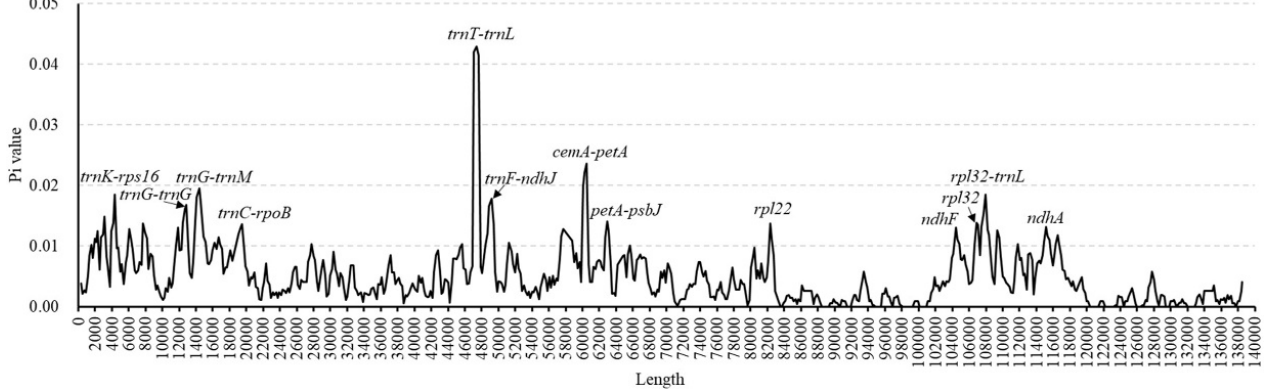
Figure 6. Nucleotide diversity (Pi) was determined by sliding window analysis of the aligned whole cp genomes of the 16 Leymus species (window length: 600 bp; step size: 200 bp). The X -axis represents the position of the midpoint of the window and the Y -axis represents the Pi of each window.